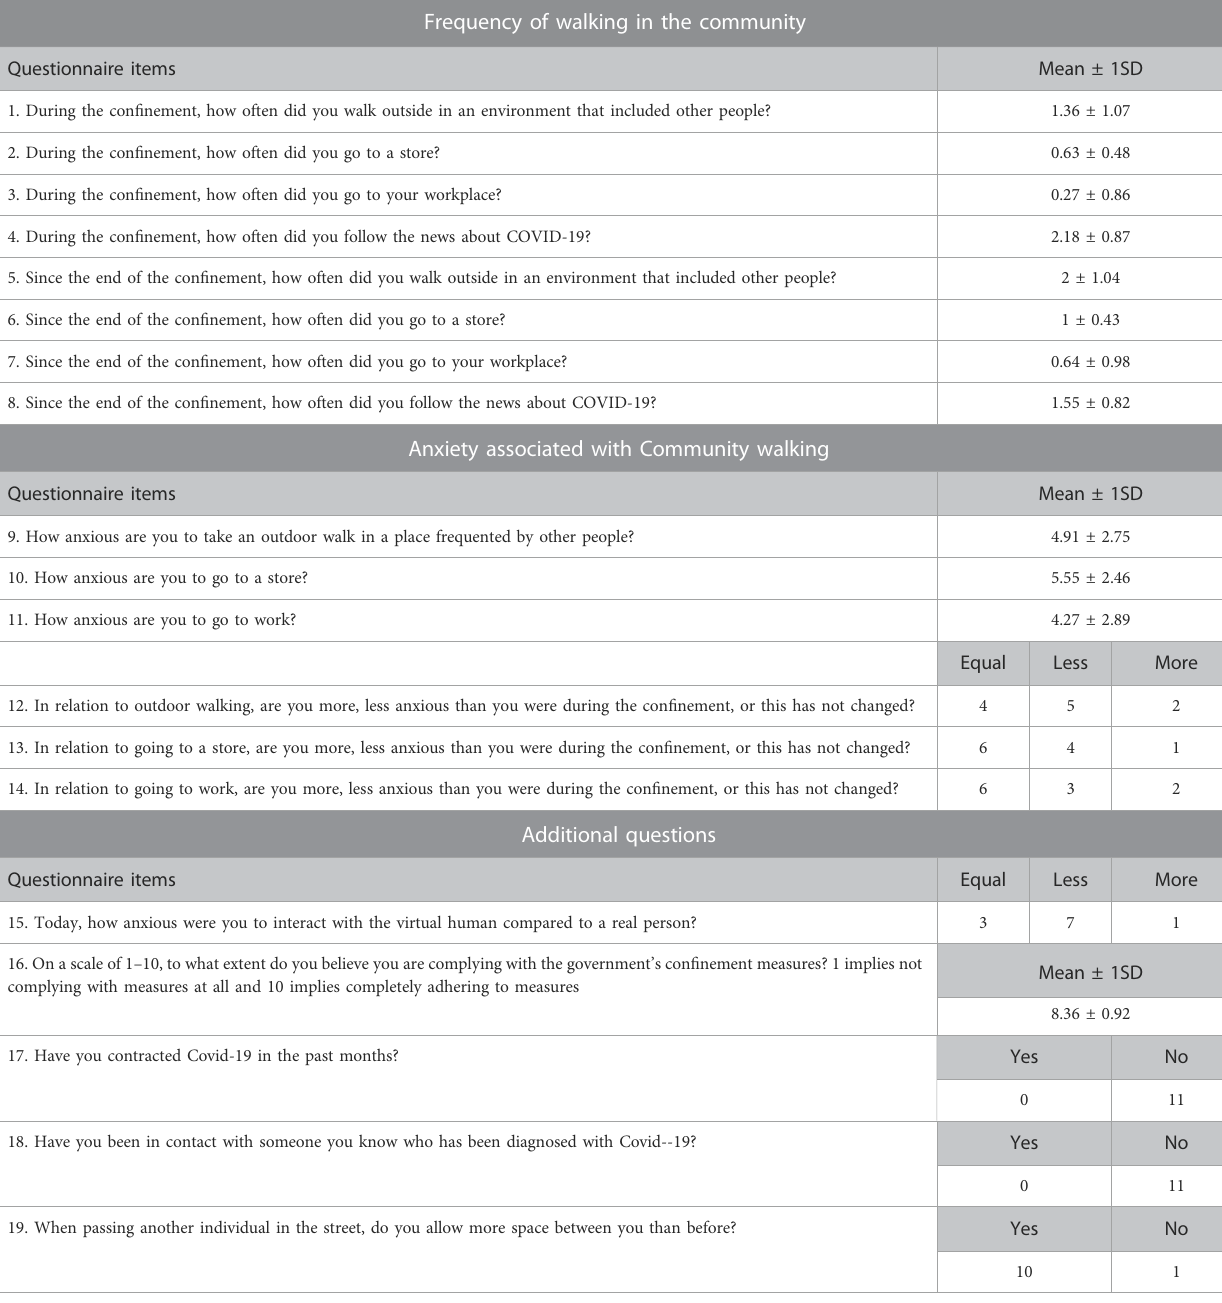
TABLE 1 Custom-made questionnaire on community walking behaviour and anxiety related to the COVID-19 pandemic. List of questions that were used to measure the frequency of community walking during and after the con fi nement period, and self-reported anxiety related to community walking. For Q1 to Q8, maximum scores are 3. Ten is the maximum score for Q9 to Q11. Mean ± 1SD values are shown for continuous outcomes and counts for categorical